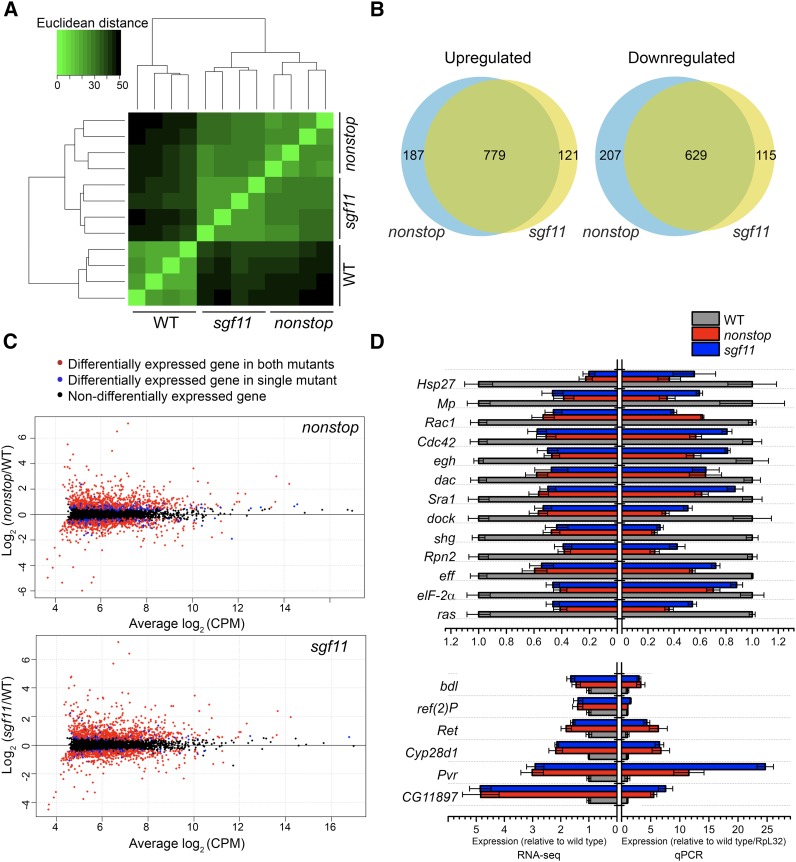
Mutations that disrupt SAGA deubiquitinase activity result in misregulated gene expression in optic lobe glia. (A) Hierarchical clustered heat map representing the Euclidean distance matrix of each genotype and biological replicate (n = 4) for RNA-seq analysis calculated based on regularized log2 transformed counts of each gene. More closely related samples are shown in light green (smallest distance, 0), and more distantly related samples are shown in black (largest distance, 50). (B) Venn diagrams indicating the number of overlapping genes that are significantly upregulated or downregulated (FDR < 0.01) in nonstop and sgf11 optic lobe glia compared to wild-type optic lobe glia. (C) Scatter plots illustrating the average differential expression of each gene (dot) in mutant/wild-type glia relative to its average expression across all samples. Each gene is plotted based on the log2 expression ratio in either the nonstop (upper panel) or sgf11 (lower panel) mutant/wild type (y-axis) relative to the log2 of its average expression level in CPM across all genotypes (x-axis). Genes that were identified as being significantly differentially regulated in both mutant genotypes are shown in red, and genes identified as significantly differentially regulated only in a single mutant genotype are shown in blue. (D) qRT-PCR analysis of transcript levels in cDNA from wild-type, nonstop, and sgf11 optic lobe glia for a subset of the differentially regulated genes was compared with fold changes observed in the RNA-seq analysis. Mean transcript levels for each gene were normalized to RpL32 and plotted relative to the wild type, which was set to one (right panel). RNA-seq result with fold change of genes of interest were plotted using raw abundance values compared to the wild type, which was set to one (left panel). Error bars denote standard error of the mean for three biological replicates for qRT-PCR analysis and four biological replicates for RNA-seq. CPM, count per million; FDR, false discovery rate; qPCR, quantitative polymerase chain reaction; RNA-seq, RNA sequencing; SAGA, Spt-Ada-Gcn5 acetyltransferase; WT, wild-type.